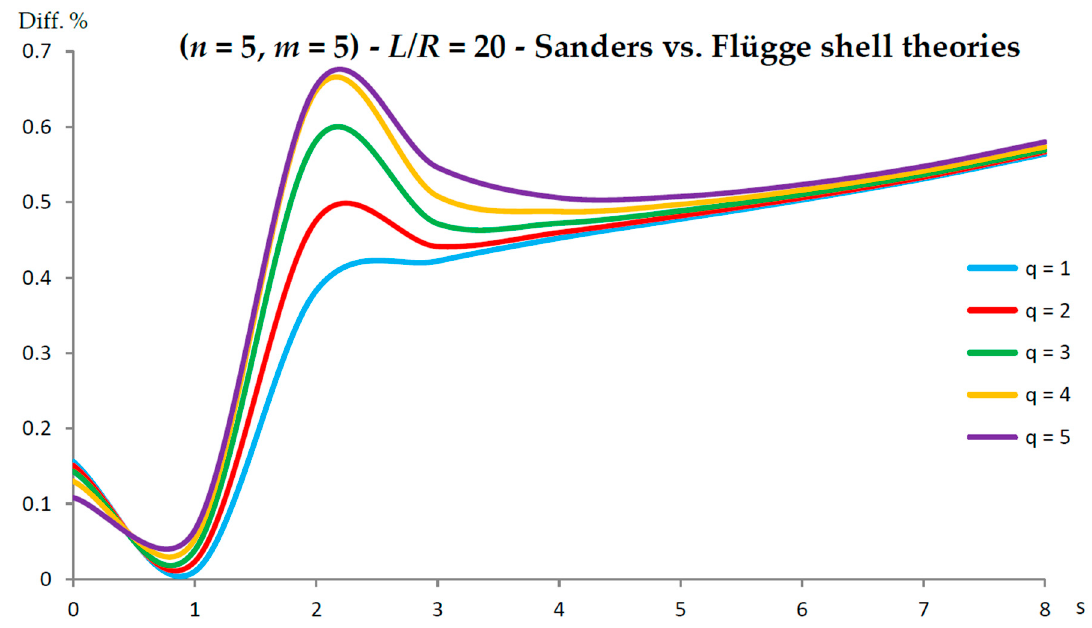
Figure 11. Percentage differences between the radial natural frequencies obtained via Sanders and Flügge shell theories (Flügge as the reference). Anisotropic elastic shell model. Simply supported SWCNT of Table 1 with chirality indices (𝑛 = 5, 𝑚 = 5) and aspect ratio 𝐿/𝑅 = 20 . Number of longitudinal half-waves 𝑞 . Number of circumferential waves 𝑠 .